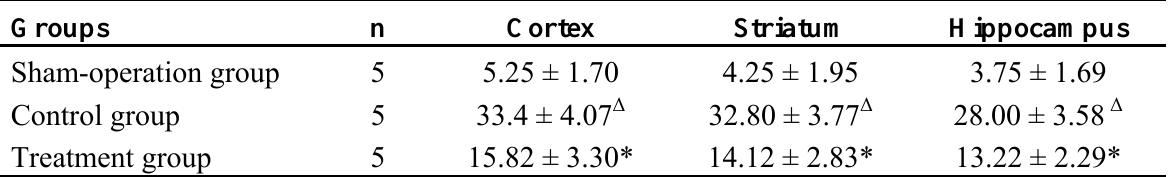
Table 3. The number of Caspase-3 positive cells ( x ±